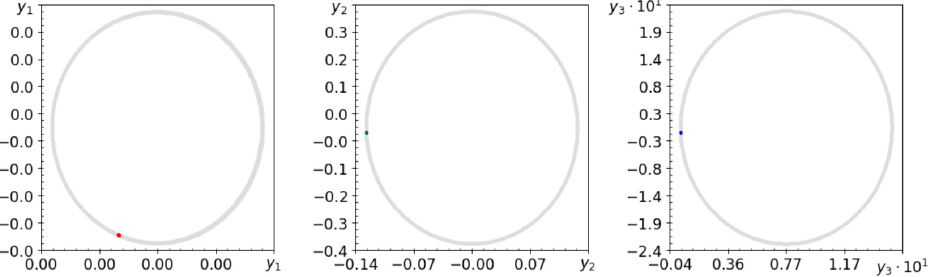
Figure 12. Phase planes and Poincar é maps (colors as above) for C = 9.05, k = 40 and ω = 3.14. Table 5. Spectra of Lyapunov exponents for the system with second mutation of rigid pendulum. Parameters